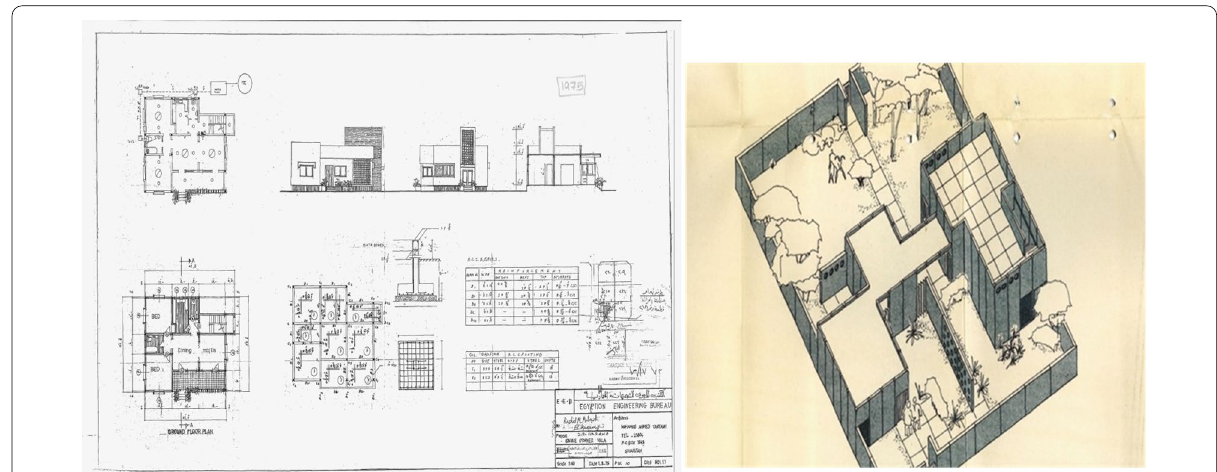
Fig. 3 On Left, example of a consolidated typology in 1975, designed by an Egyptian Engineering firm. Source: Emirati architect Moza Mohamed Rashid Saeed Abdalla. On right: Example of accretive type in 1974 on the right by Wolfgang Braun and architect Peter